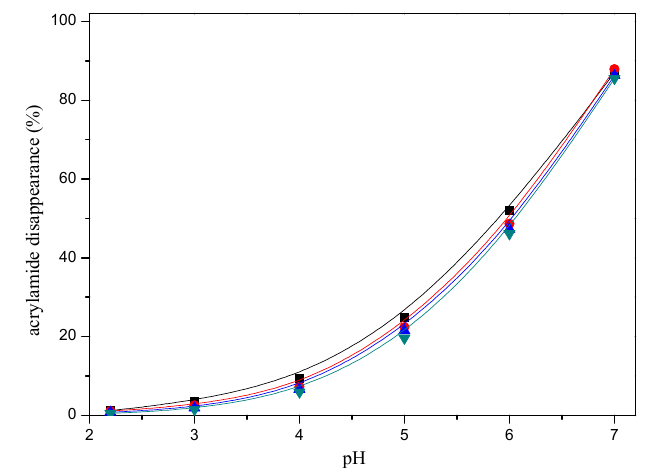
Figure 4. pH-response effect of selected mercaptans on the acrylamide disappearance after heating an acrylamide (0.2 μ mol)/mercaptans (20 μ mol) model system at 180 °C for 30 min. Mercaptans assayed were 1,2-ethanedithiol ( ■ ), 1-butanethiol ( ▲ ), 2-furanmethanethiol ( ▼ ), and 2-methyl-3- furanthiol ( ● ).